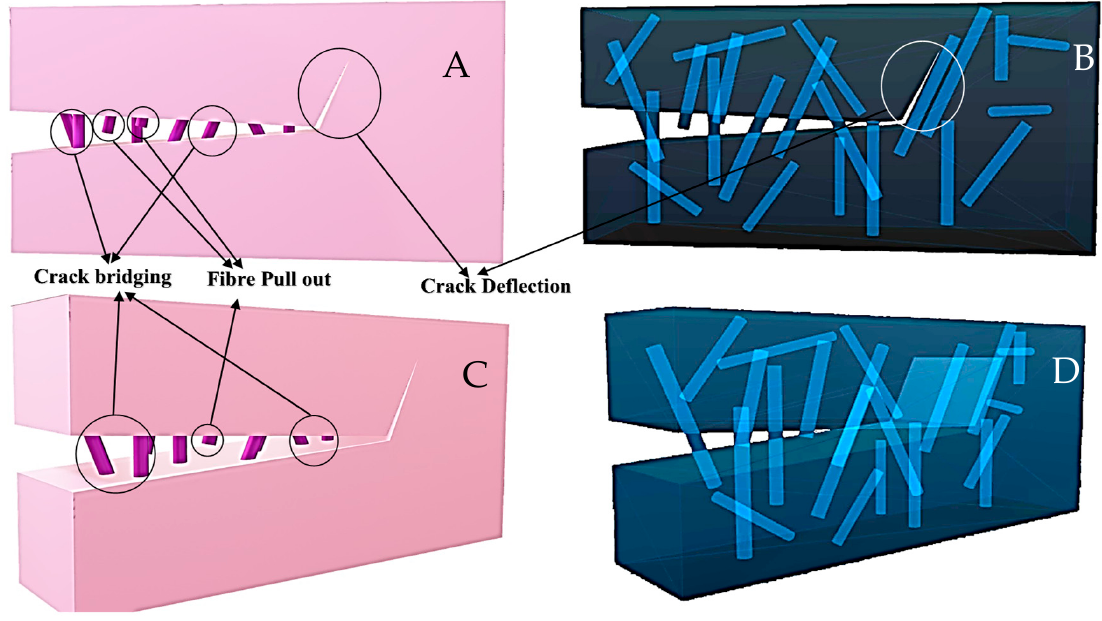
Figure 3. A typical representation of strengthening and toughening by fibres; ( A , C ) represent two views of crack in a body being perturbed by fibres, ( B , D ) represents the see-through image of the body presented in A and C, for a better understanding of the reinforcement effects.